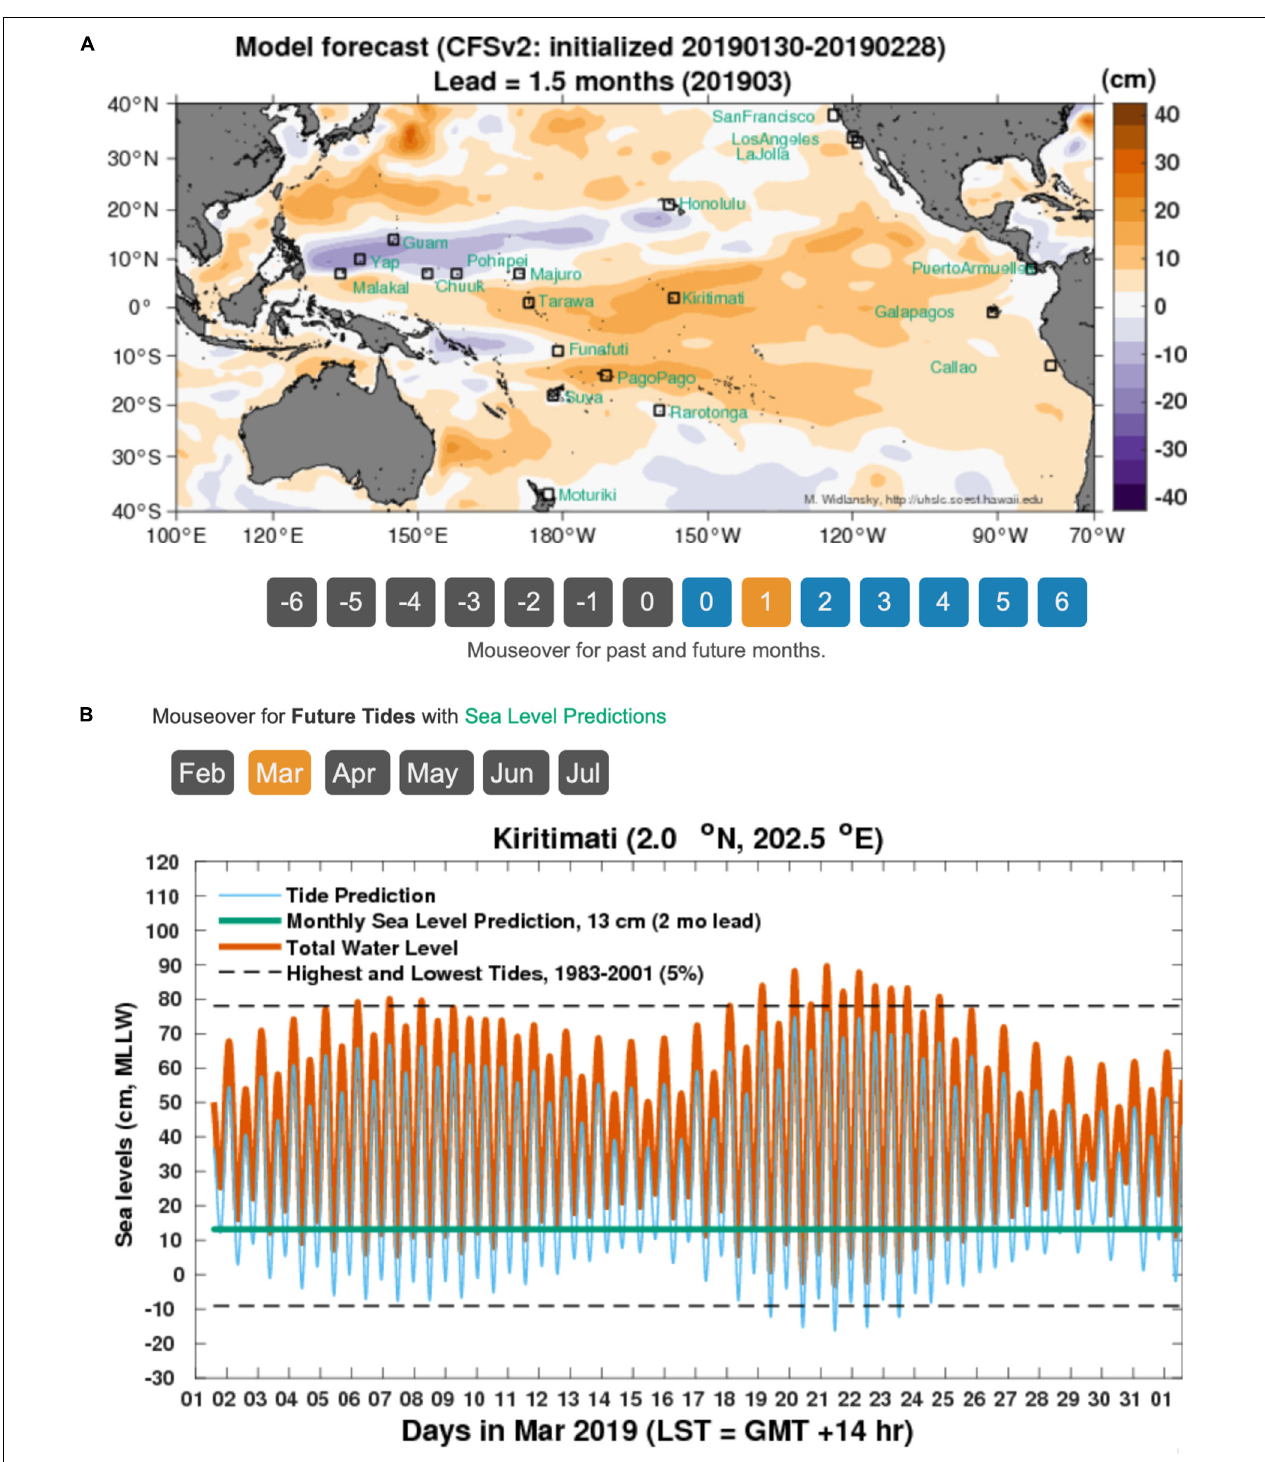
FIGURE 10 | University of Hawai’i Sea Level Center’s seasonal forecast product of monthly mean sea level (Widlansky et al., 2017). (A) Sea level forecast for the tropical Pacific with 1 month lead from an operational forecast model. (B) Astronomical tide predictions plus forecasted mean sea level with 1 month lead for the island of Kiritimati. The combination of tides plus mean sea level provides a more accurate forecast of high tide and potential impacts compared to astronomical predictions alone.